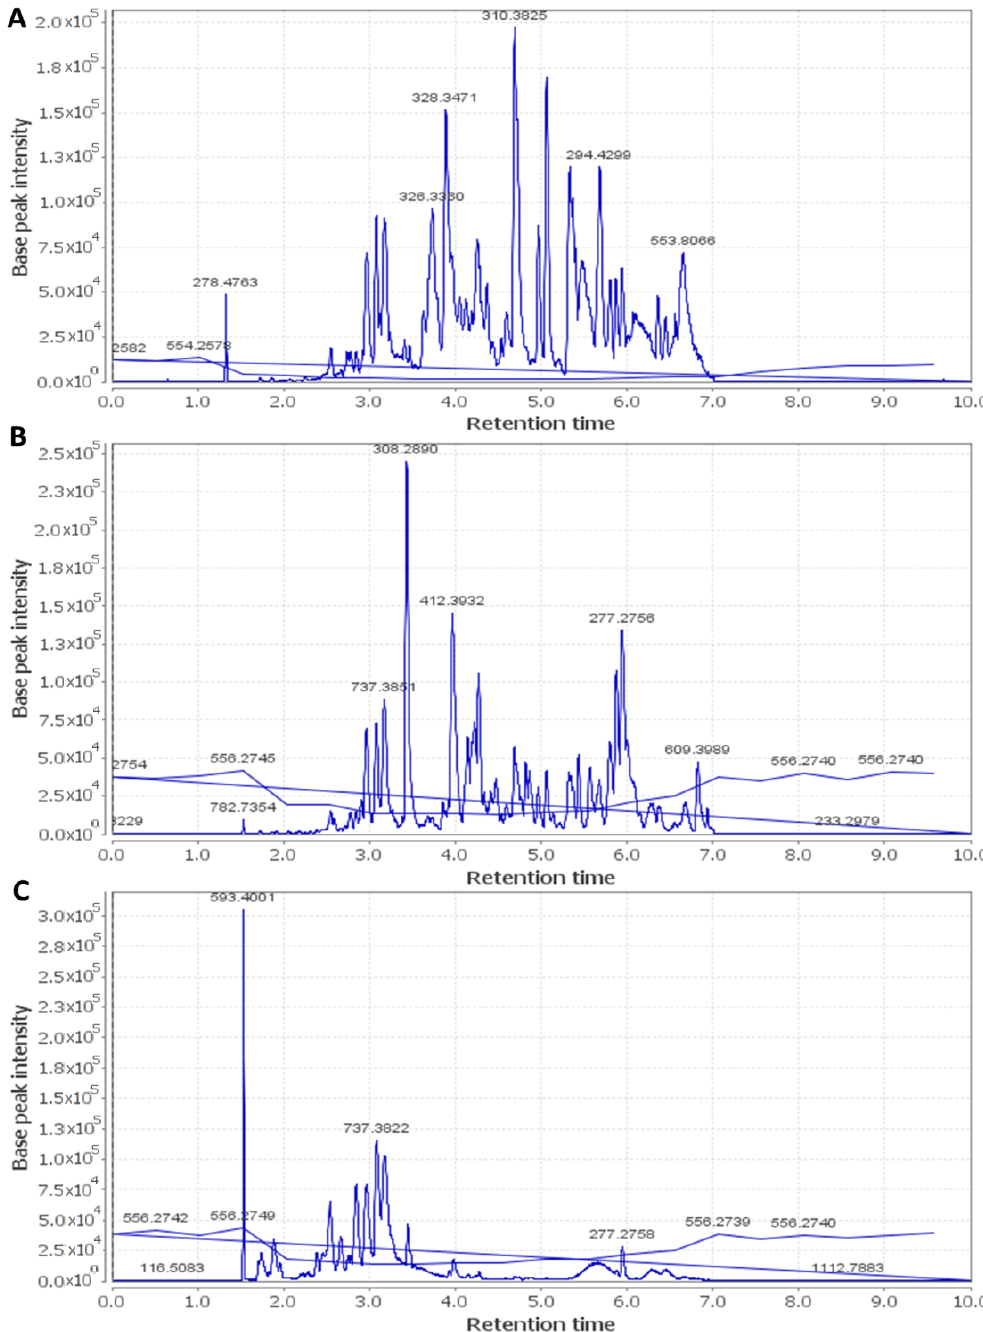
Figure 2. Total ion chromatogram of Hibiscus schizopetalus recorded in positive ionization mode. ( A ) Ethanolic extract (Et-E); ( B ) Dichloromethane faction (DCM-F); ( C ) n-Butanol fraction (Bu-F). 2.0 × 10 5